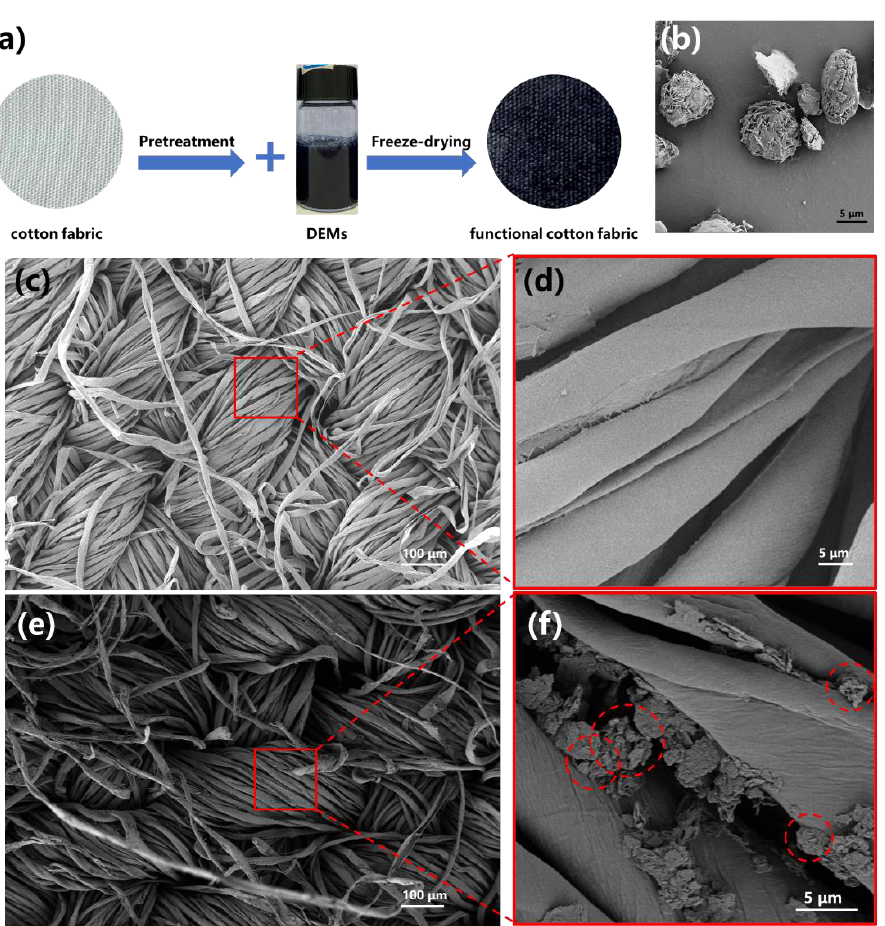
Figure 2. ( a ) Schematic diagram of the preparation of functional cotton fabrics; Scanning Electron Microscopy (SEM) images of ( b ) DEMs, ( c ) untreated cotton fabrics and ( e ) DEMs-cotton fabrics; Enlarged partial SEM images of ( d ) untreated cotton fabrics and ( f ) DEMs-cotton fabrics. The changes of the surface chemical structure were analyzed by FT-IR. As shown in Figure 3a, the characteristic absorption band of untreated cotton fabrics and DEMs-cotton fabrics was observed at 3341 cm − 1 , corresponding to the stretching vibration of OH